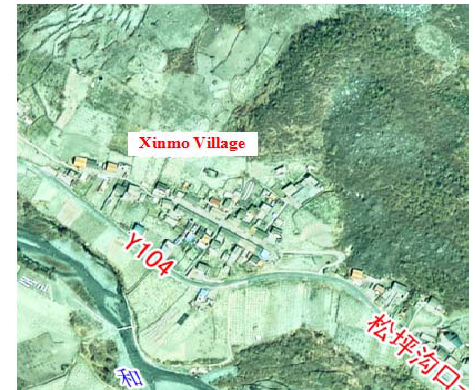
Figure 9. Pre-Disaster Image of Xinmo Village ((Technology Innovation Center of Emergency Surveying and Mapping, 2017)